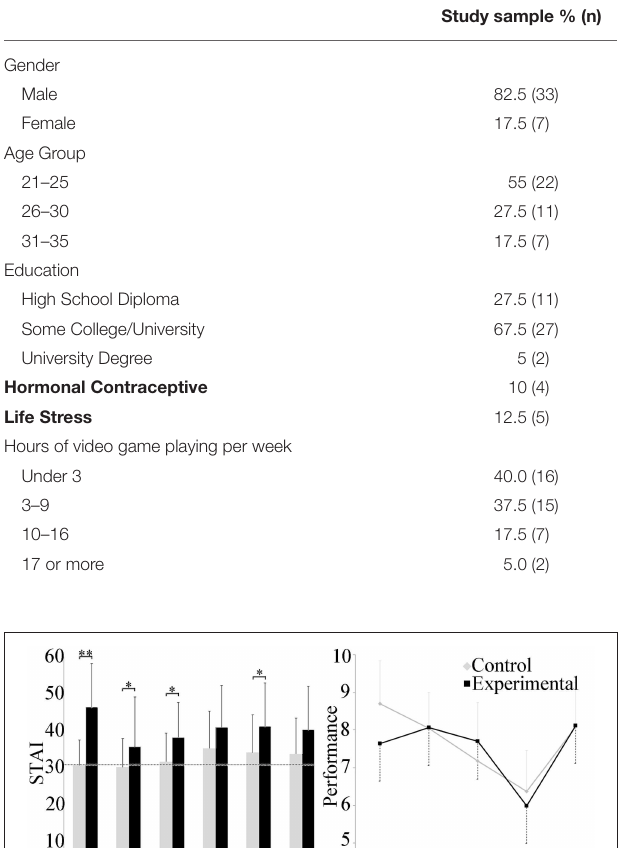
TABLE 1 | List of sociodemographic factors of study sample.